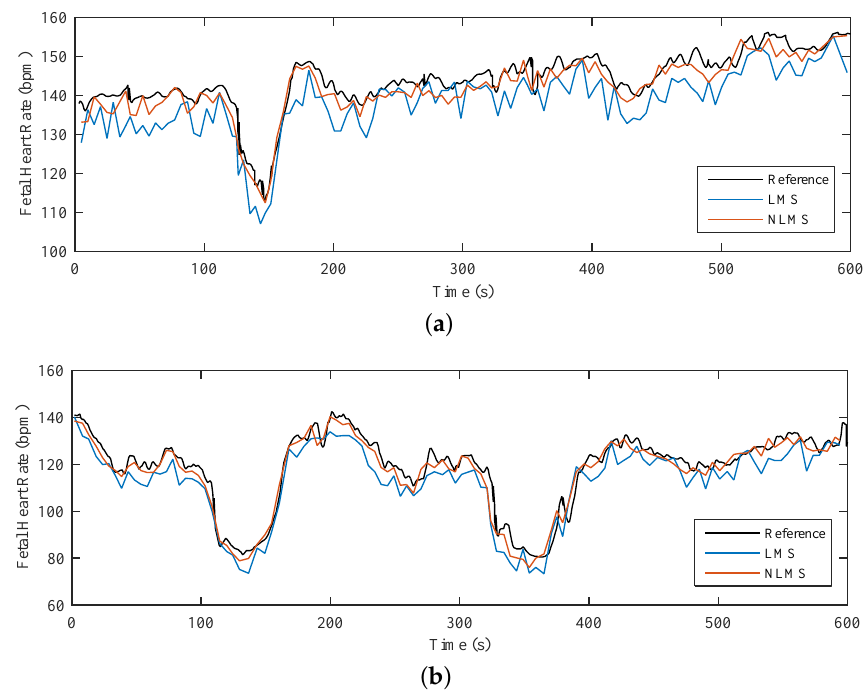
Figure 13. Comparison of reference and predicted time course of fHR ( a ) physiological case; ( b ) pathological case.